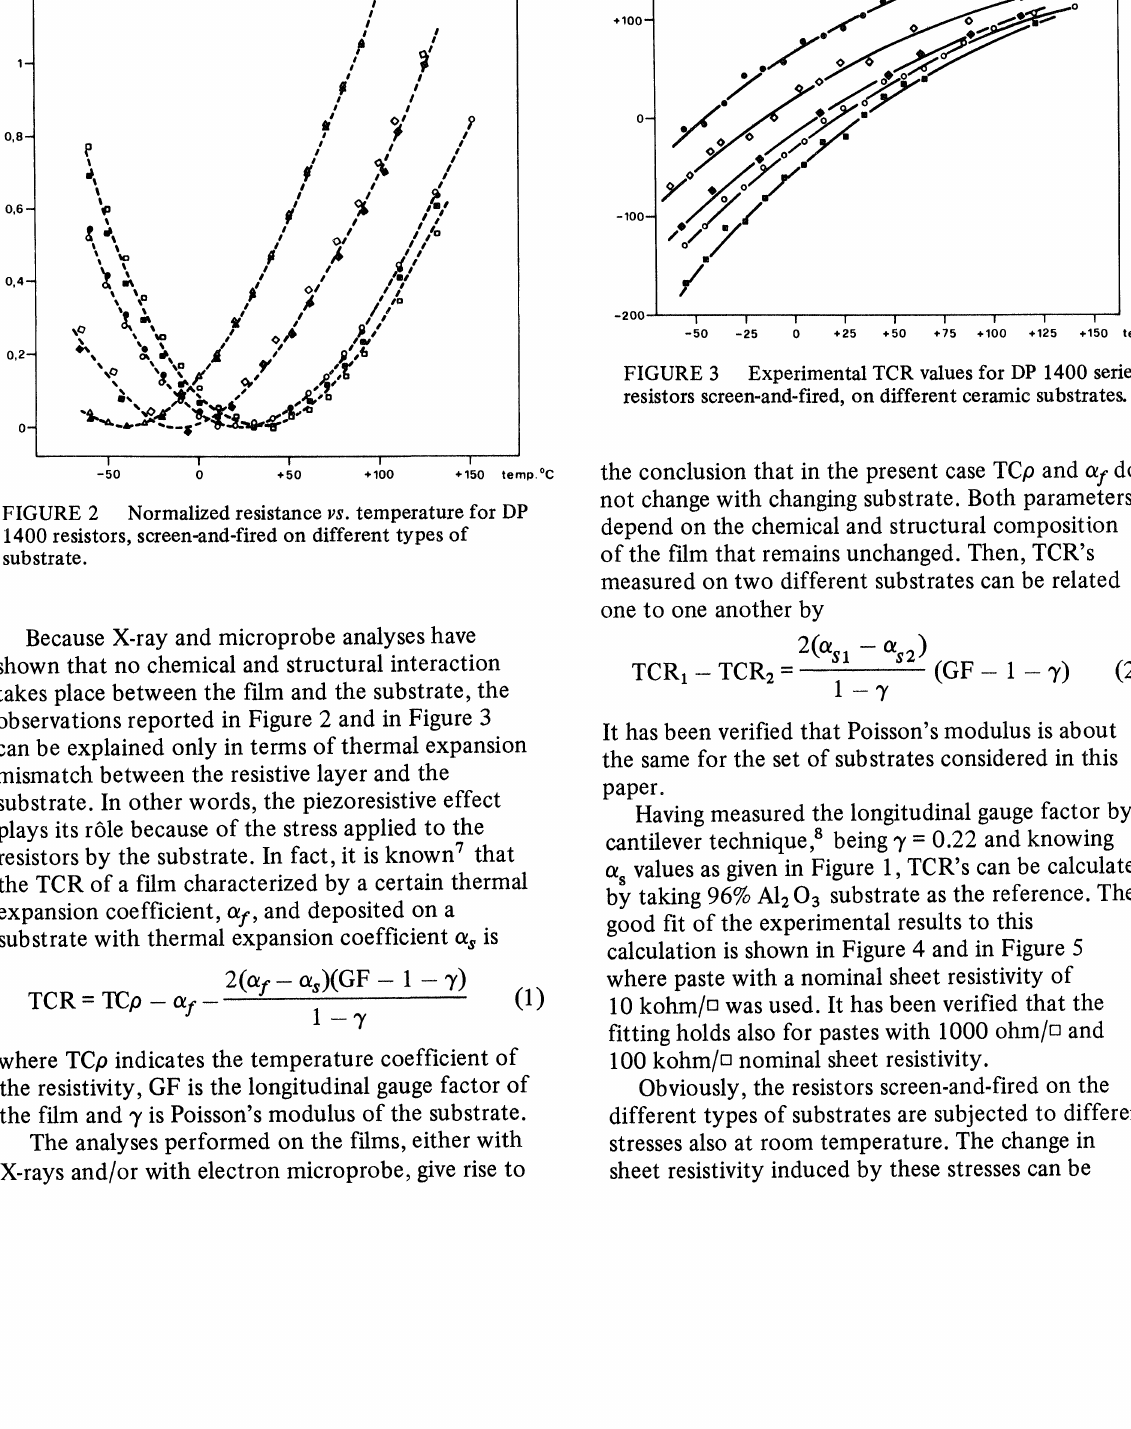
FIGURE 3 Experimental TCR values for DP 1400 series resistors screen-and-fired, on different ceramic substrates. the conclusion that in the present case TCp and a.